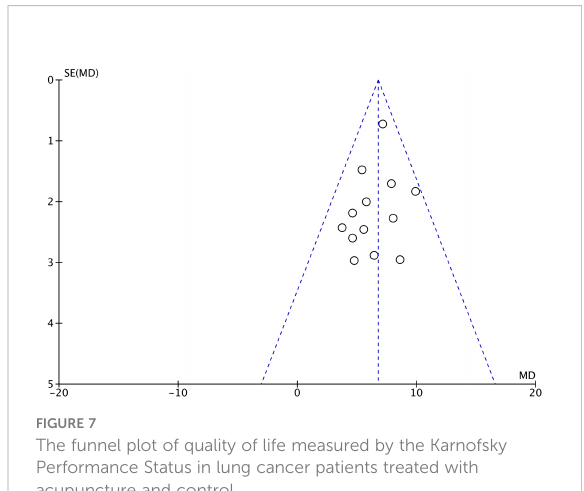
FIGURE 7 The funnel plot of quality of life measured by the Karnofsky Performance Status in lung cancer patients treated with acupuncture and